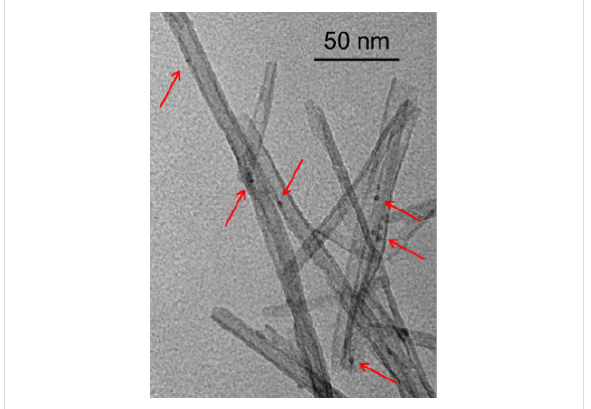
Figure 7: Representative TEM image of titanate nanotubes with immobilized PdNP (arrows). Adapted with permission from [137], © 2016 John Wiley and